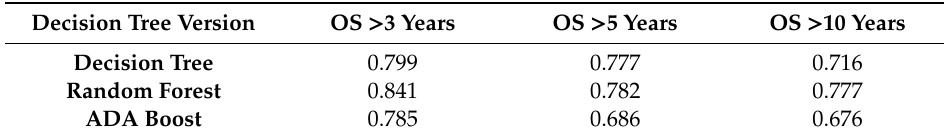
Table 6. Classification accuracy resulting from leave-one-out evaluation using three machine learning approaches based on decision trees. The results are divided by the three OS threshold